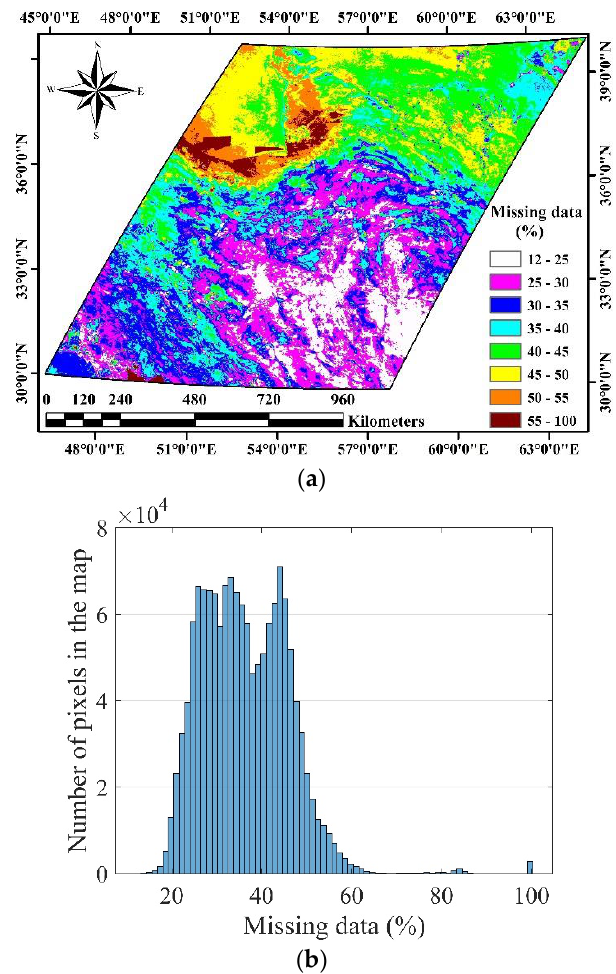
Figure 5. Percentage of gaps in each pixel of an annual LST time series with 730 images ( a ) and its histogram ( b ).